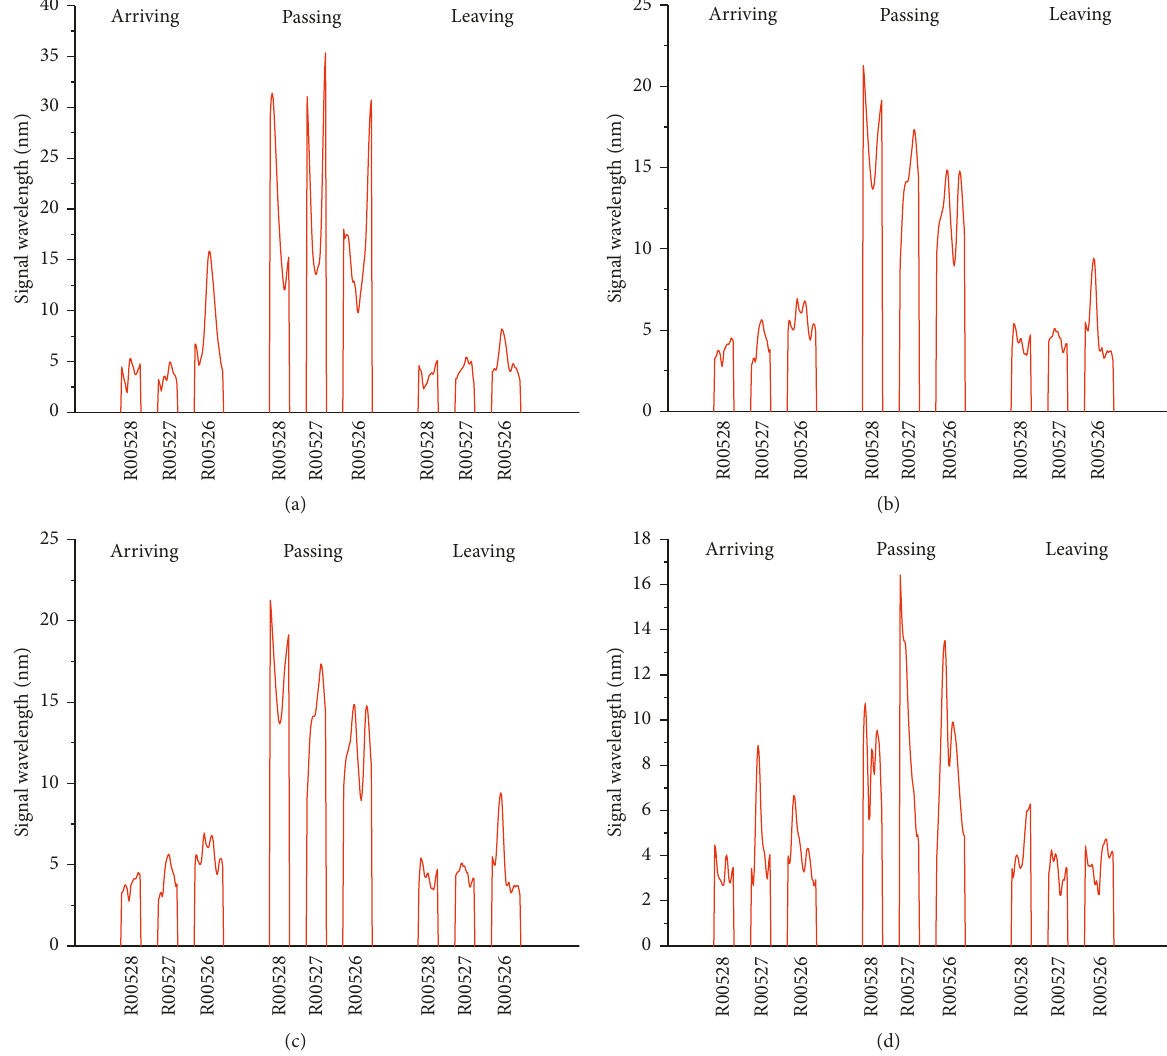
Figure 16: Vibration signal of the left track line before L00526 repair: (a) 1 st Train; (b) 2 nd Train; (c) 3 rd Train; (d) 4 th